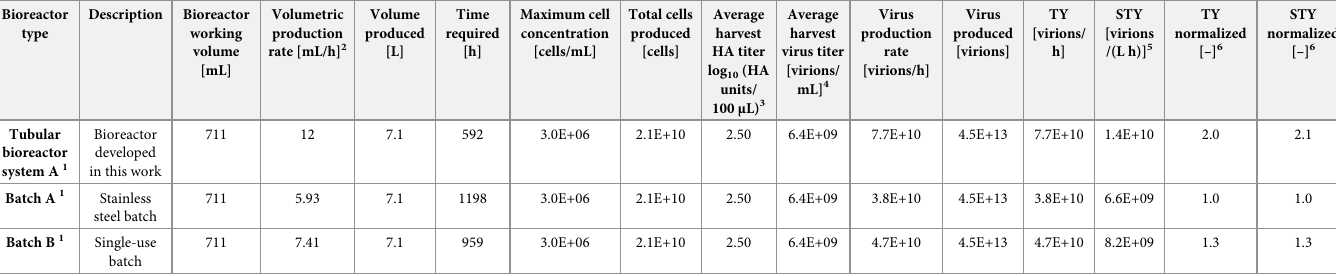
Table 1. Productivity comparison of a continuous tubular bioreactor system versus a batch production system for production of influenza A